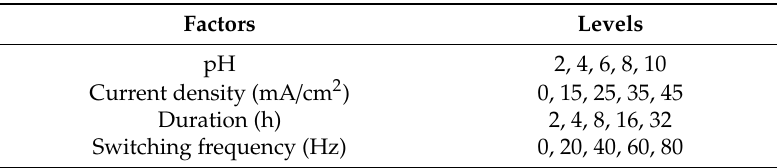
Table 1. Experimental arrangement.